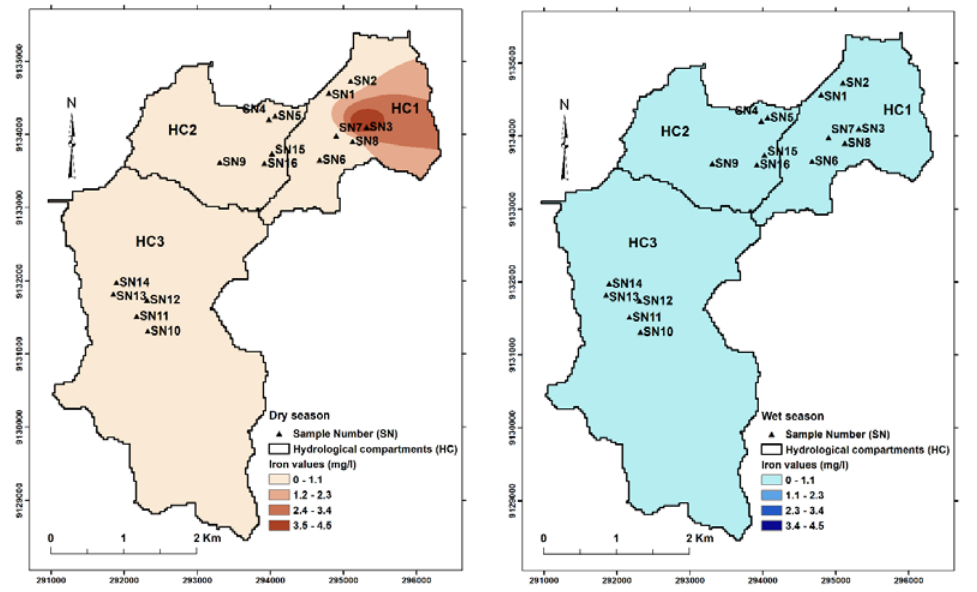
Figure 6. Spatial distribution of total iron during the dry and wet seasons in the three hydrological